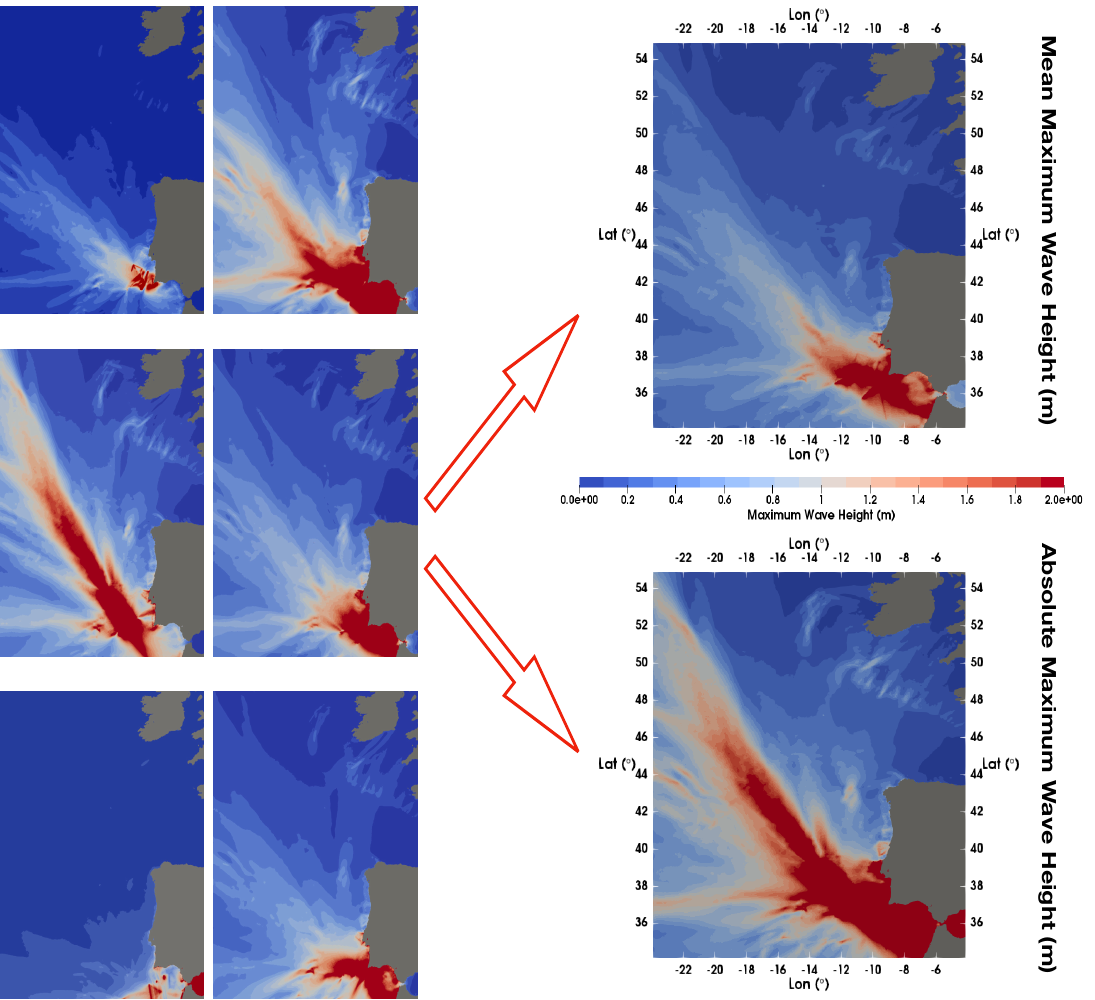
Figure 1. ( Left Figure ): Maximum wave heights from each of the six independent simulations. ( Right Figures ): The combined mean maximum wave heights and absolute maximum wave